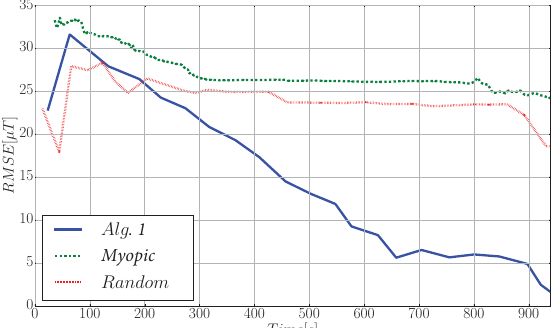
Figure 11. Evolution of the RMSE during a 940 s exploration task that was carried out with a ground-based robot in our